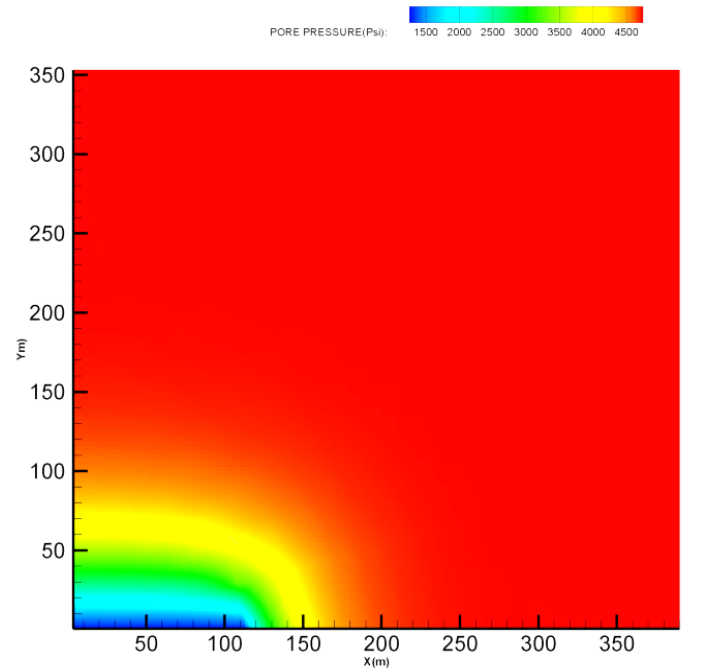
Figure 3. The gas pressure distribution around the wellbore and inside the fracture after 10 days of production for Pi = 5500 psi, Pwf = 1000 psi and k-0.01 md.